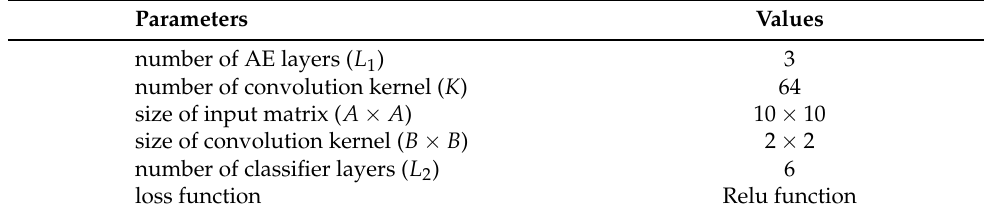
Table 3. System parameters of the CAE